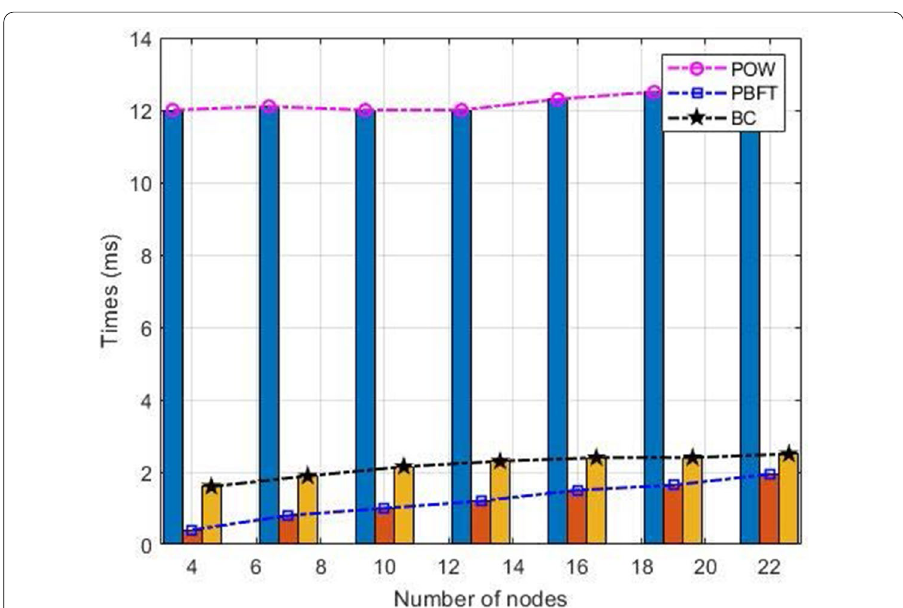
Fig. 8 Average computing time; Illustration of the Average computing time